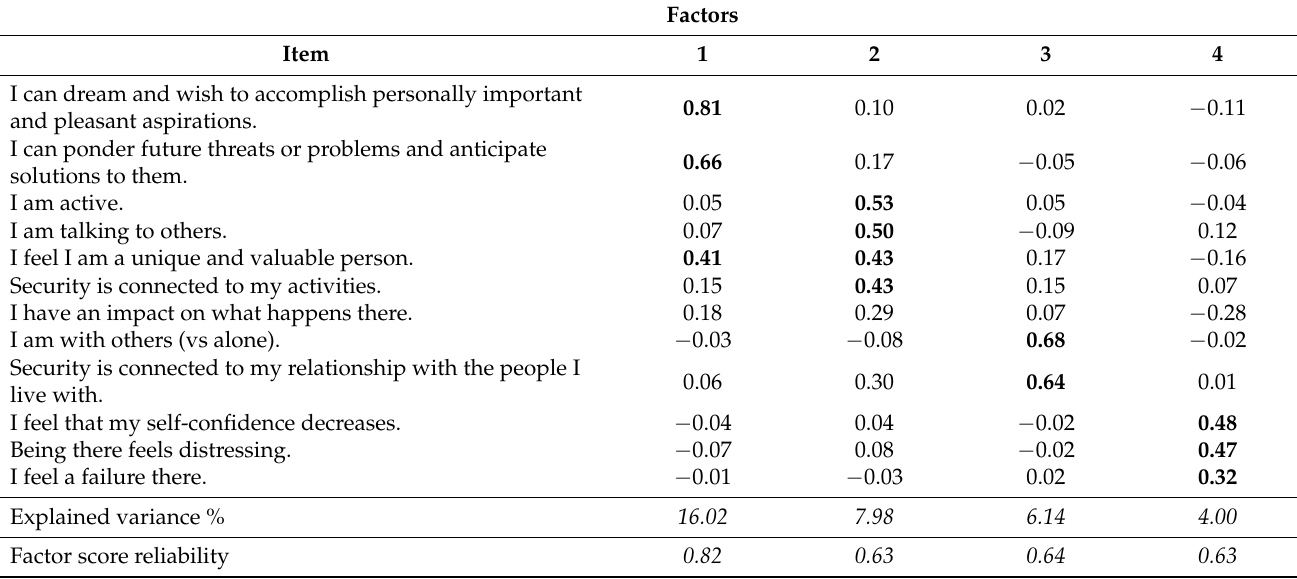
Table 3. Principal axis factoring of the place of security